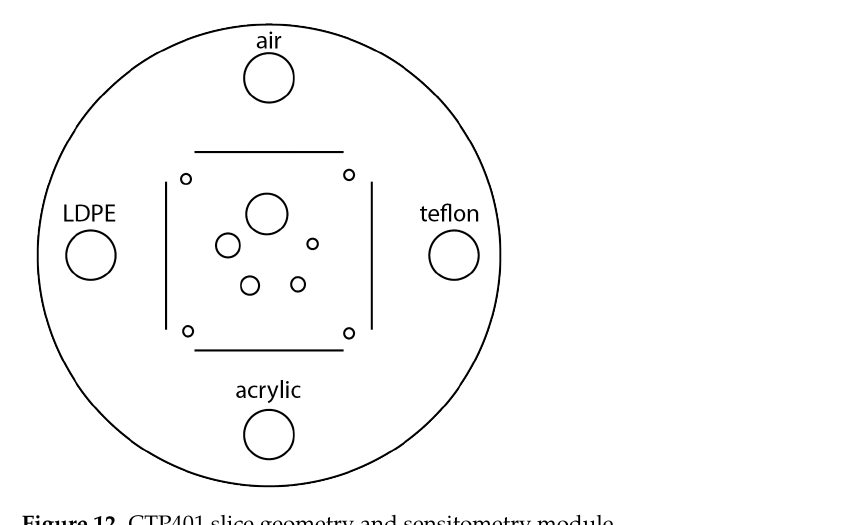
Figure 12. CTP401 slice geometry and sensitometry module.